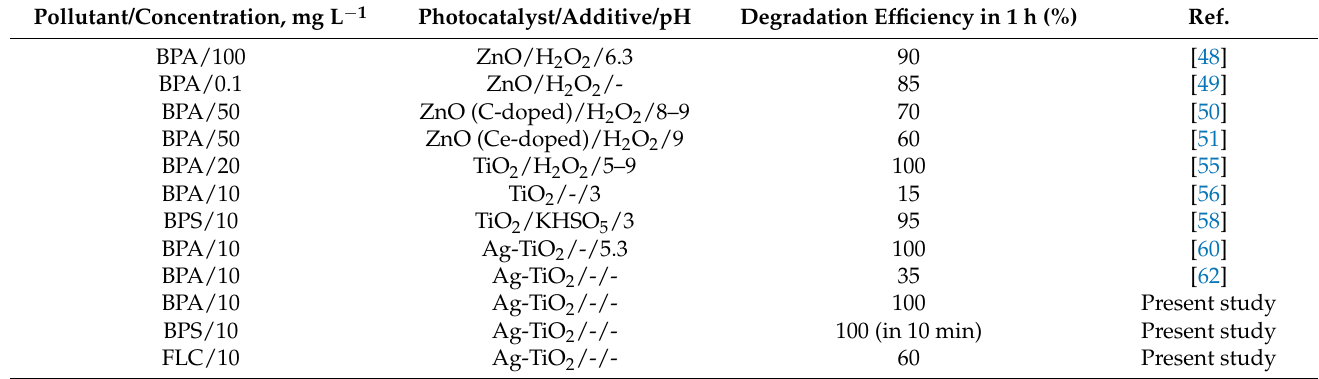
Table 2. Degradation of BPA, BPS, and FLC under different experimental conditions reported in the